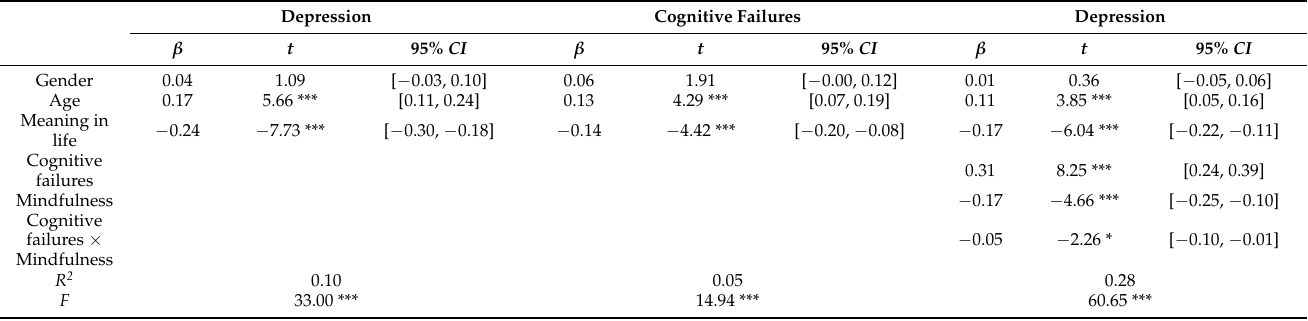
Table 2. Testing the moderated mediation model ( n =